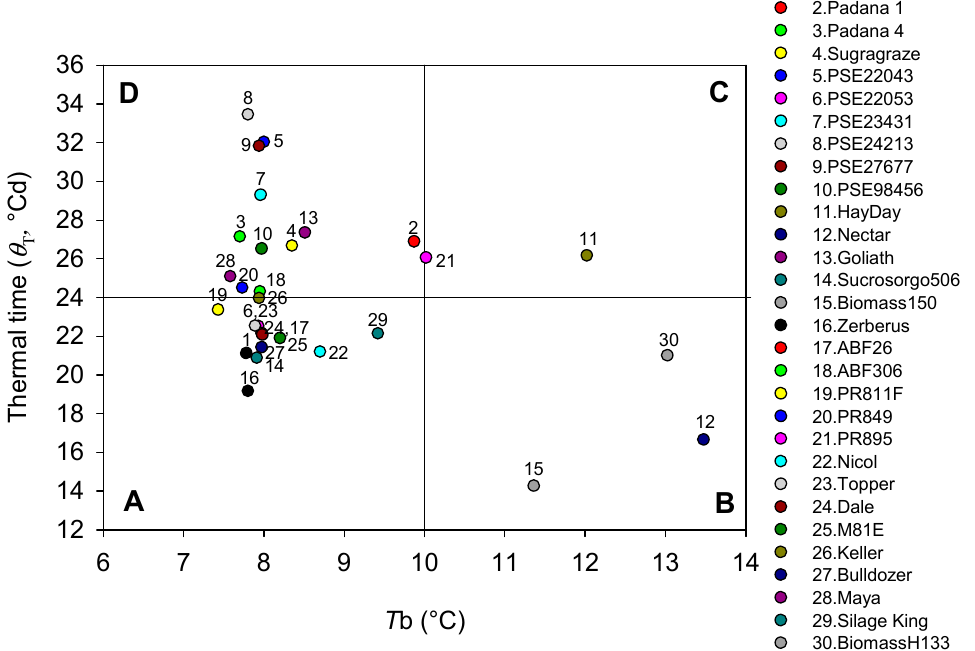
Figure 3. Thermal time ( θ T ) vs. base temperature ( T b) in the thirty cultivars of sorghum.